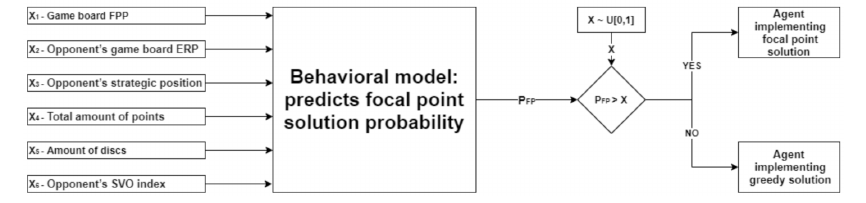
Figure 1. Adaptive agent—game